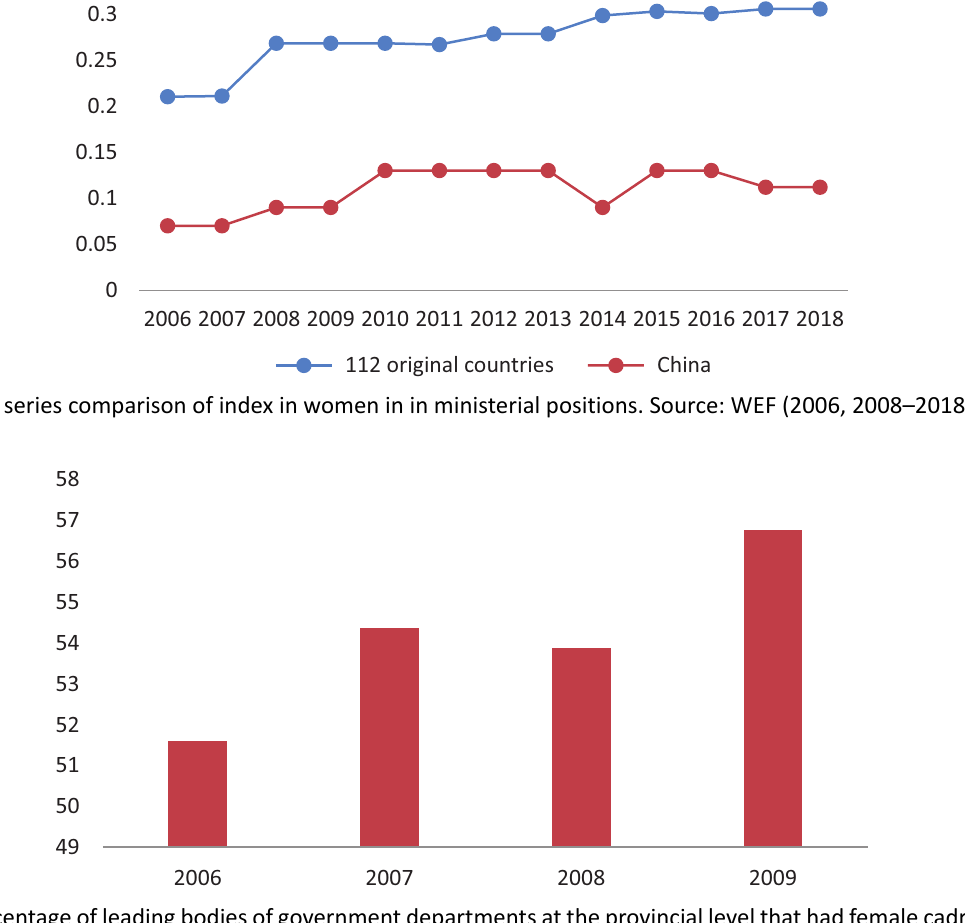
Figure 10. Percentage of leading bodies of government departments at the provincial level that had female cadres. Source: CEDAW